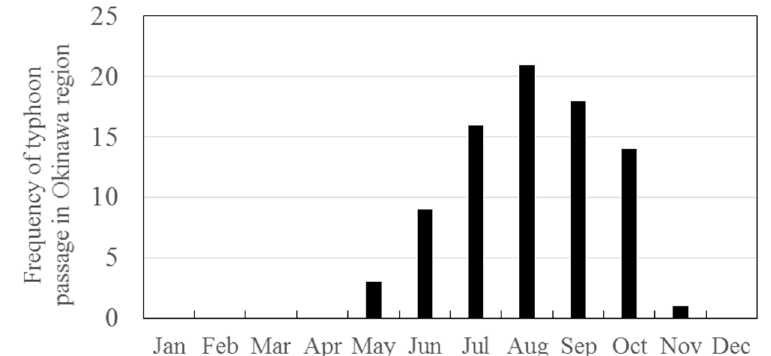
Figure 8. Frequency of the typhoon passage through the Okinawa region.